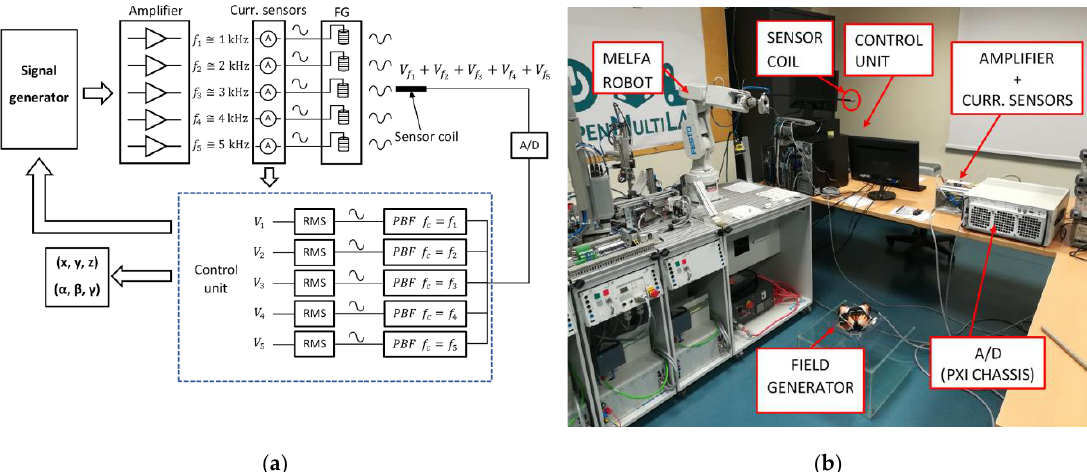
Figure 1. ( a ) Electromagnetic tracking system (EMTS) architecture; the signals produced by a signal generator are amplified, providing the excitation currents for the five transmitting coils. The total magnetic field induces a voltage in the sensor coil, which is digitalized and filtered, obtaining five RMS voltage components, V i , i = 1, ... , 5, relating to the di ff erent excitation frequencies. These components are then used for the estimation of the sensor position. Moreover, five Hall e ff ect sensors measure the excitation currents for the current control loop. ( b ) Experimental setup.